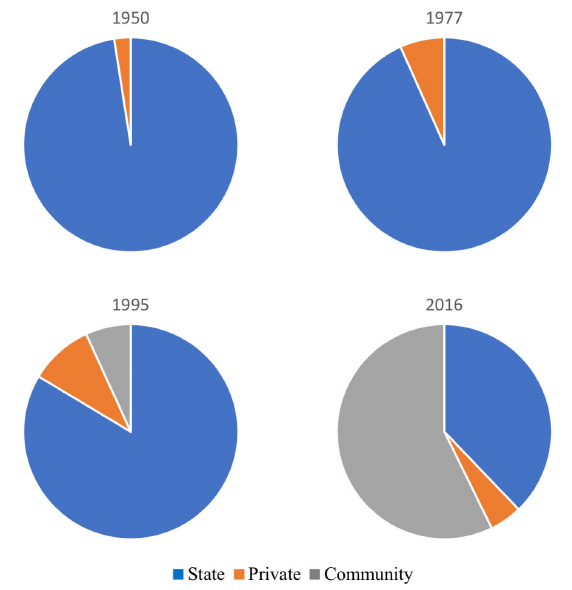
Fig. 4 . Proportion of land under state, private, and community conservation approaches at important time points for Kenyan conservation policy.